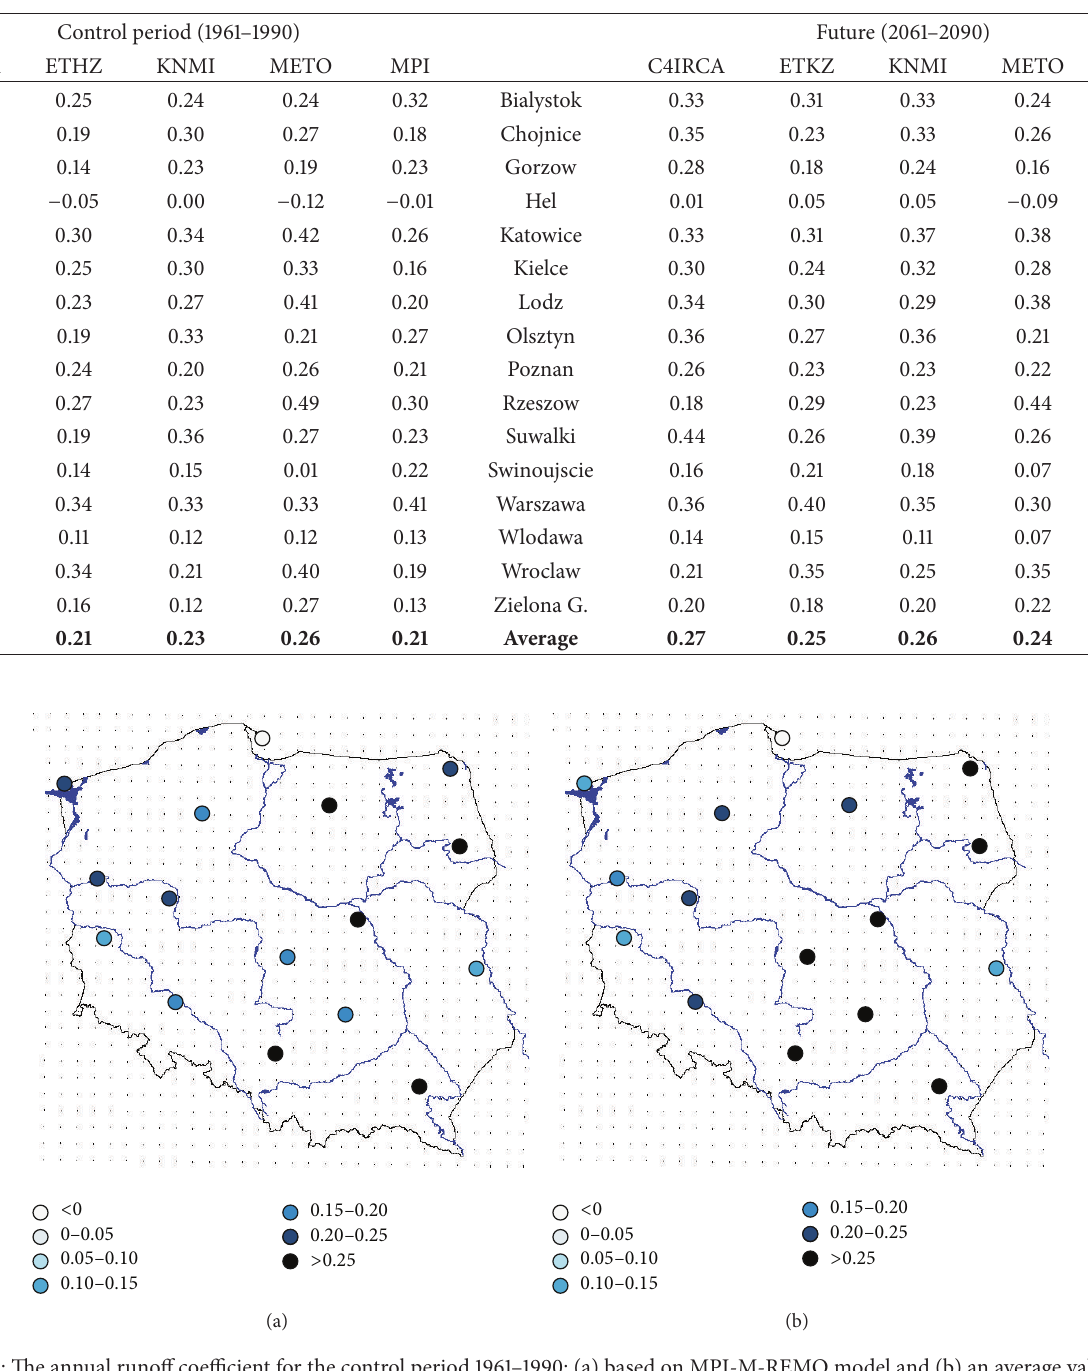
Table 11: The annual runoff coefficient for the control period 1961–1990 and for the future 2061–2090 based on five models.